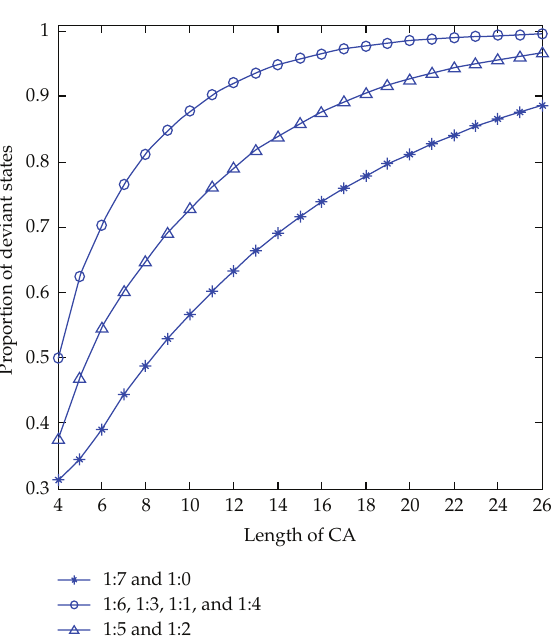
Figure 4: Plot of proportion of deviant states versus length of CA (cid:2) periodic bound (cid:3) for various subclasses of Class